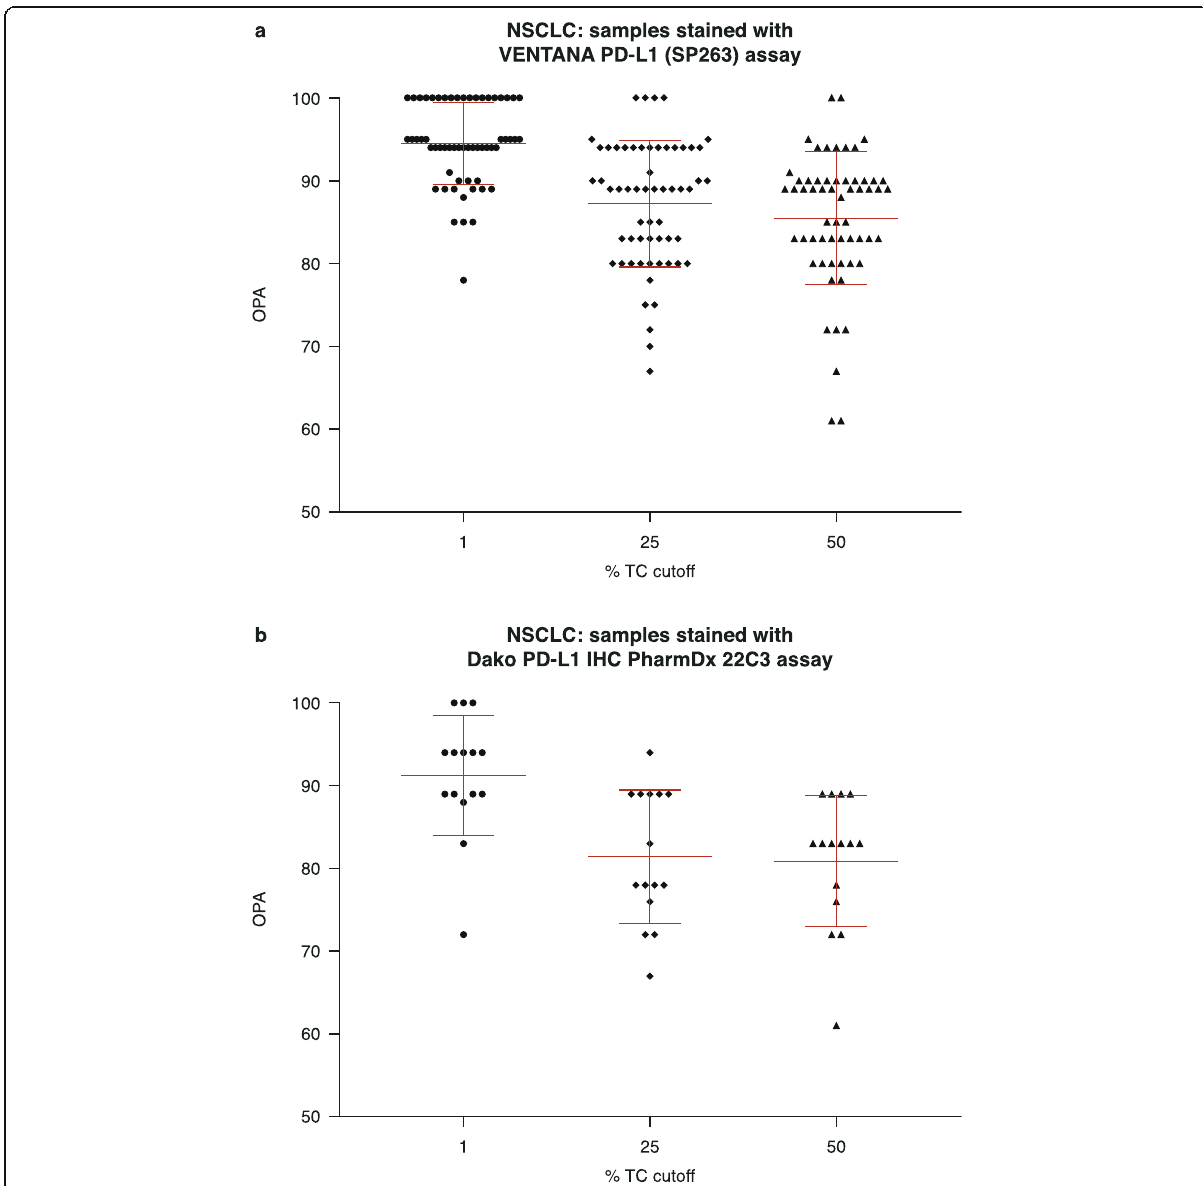
Fig. 1 Overall percentage agreement (TCs) between board-certified pathologists ’ scoring for NSCLC using ( a ) the VENTANA PD-L1 (SP263) assay ( n = 59) and ( b ) the Dako PD-L1 IHC PharmDx 22C3 assay ( n = 15), NSCLC, non-small cell lung cancer; OPA, overall percentage agreement; TC, tumour cell. Red lines represent standard deviation. Assays were carried out according to manufacturers ’ recommended